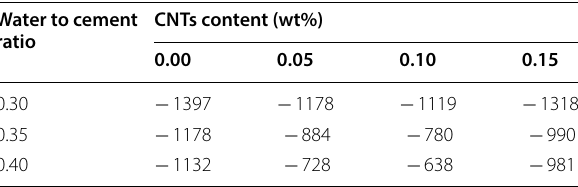
The negative sign in the table represents the contraction